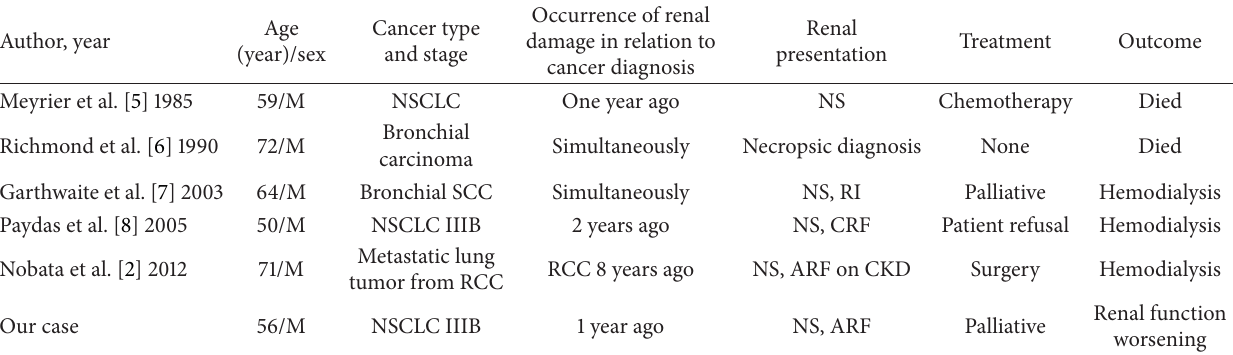
Table 1: Biopsy-proven renal AA Amyloidosis associated with lung